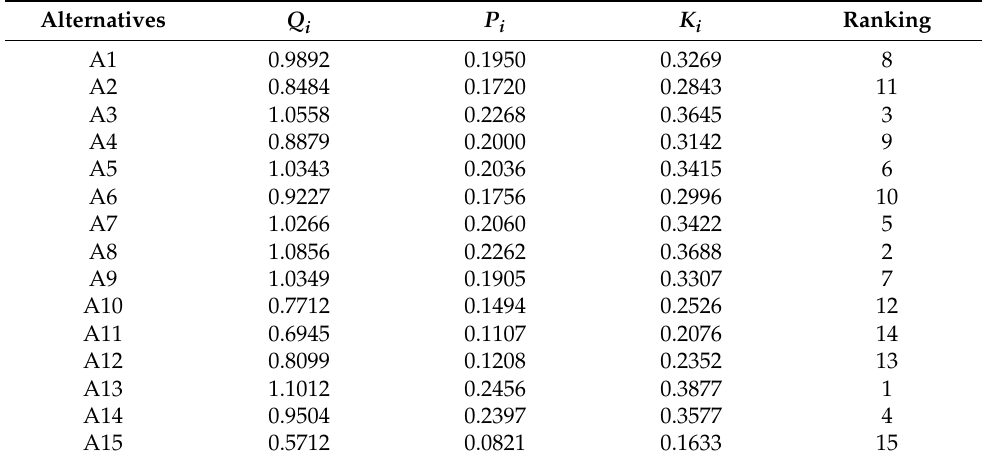
Table 9. Ranking the results of the WASPAS-F